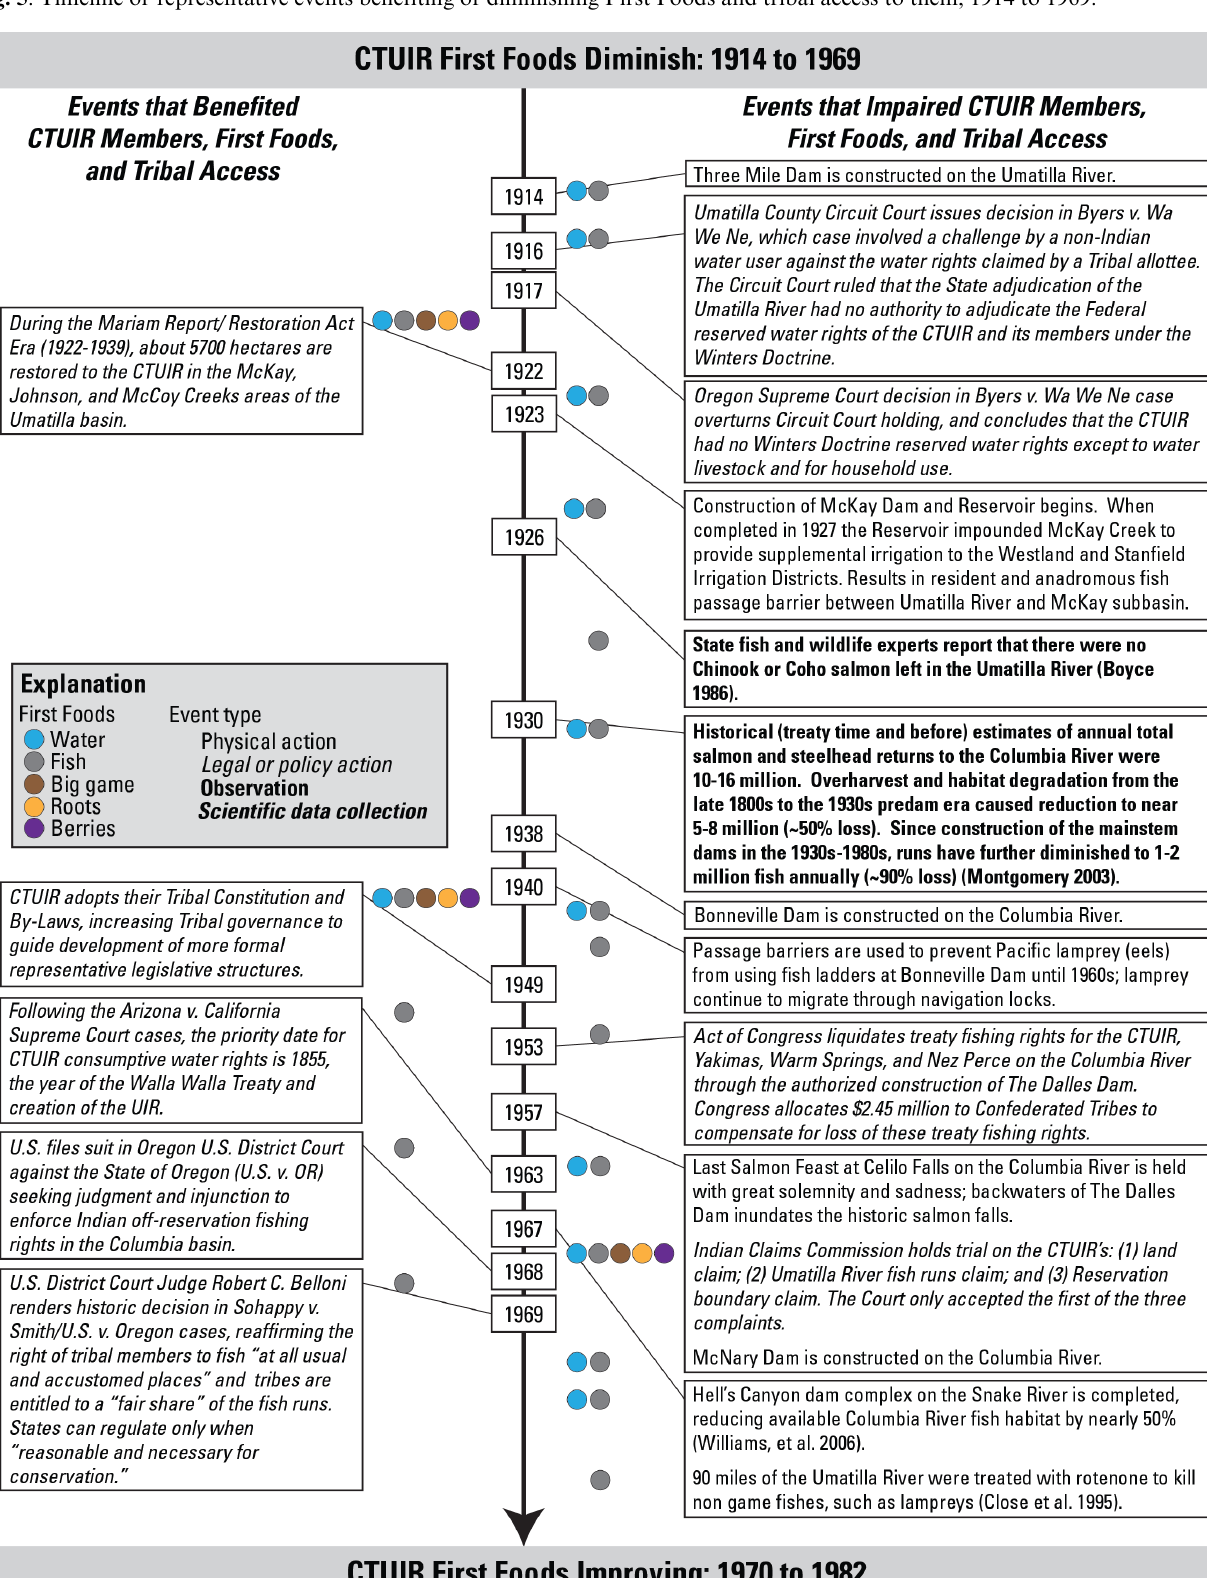
Fig. 5 . Timeline of representative events benefiting or diminishing First Foods and tribal access to them, 1914 to